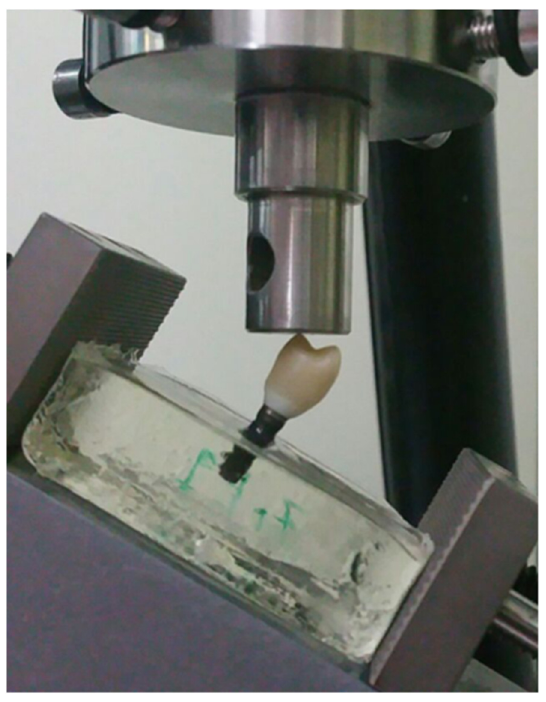
Figure 2. Test set-up following ISO 14801.